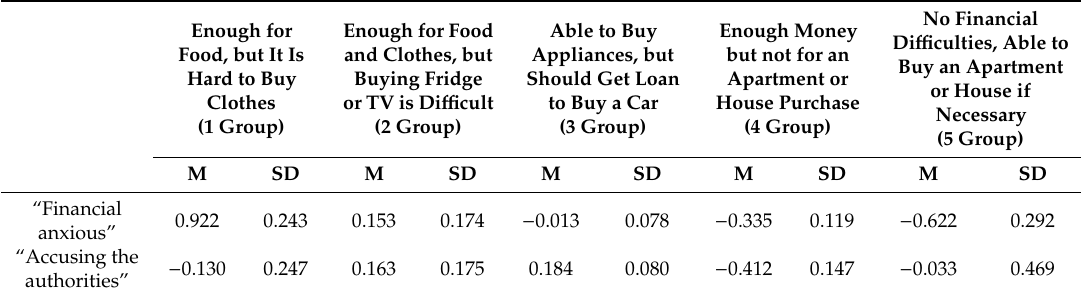
Table 4. Significant di ff erences between groups with di ff erent assessments of the socio-economic status of the family (N =